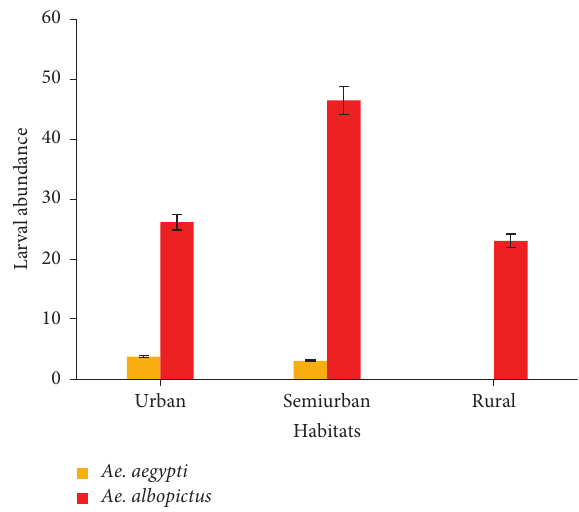
Figure 2: Relative abundance of Aedes spp. larvae in three selected Table 1: Occurrence of Aedes aegypti and Aedes albopictus in different container types. Type of containers